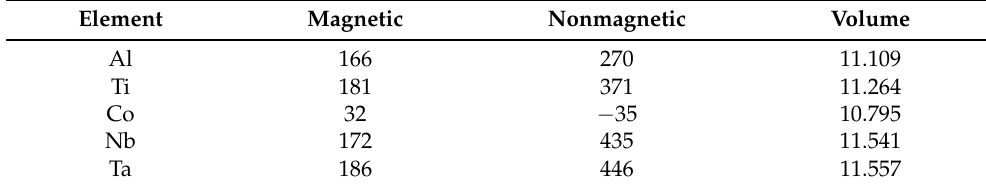
Table 3. Nearest-neighbor interaction energy (in meV) between Cr and other alloying atoms calculated in a matrix with 108 atoms. Results for both spin-polarized and non-polarized calculations are shown. 3 Additionally shown are the atomic volumes (in units Å ) of the elements in a (spin-polarized) Ni 107 X cell, calculated by a Voronoi construction. Element Magnetic Nonmagnetic